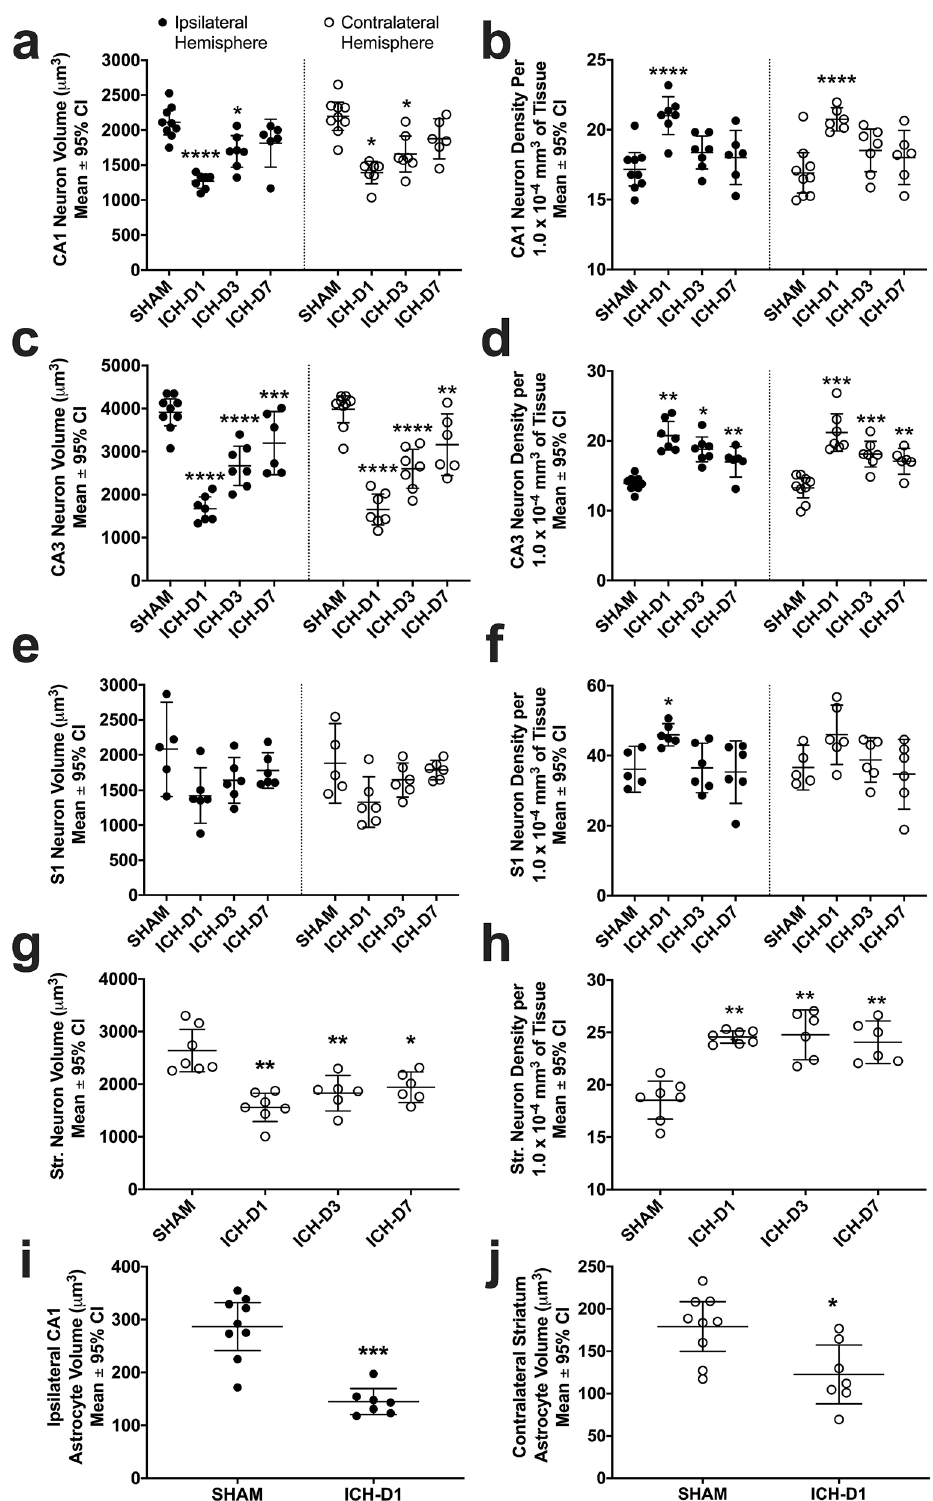
Figure 2. In experiment 1, neuron soma volume ( a , c , e , g ) and density ( b , d , f , h ) were analyzed with unbiased stereology on days 1, 3, and 7 following striatal ICH or sham operation. Astrocyte soma volume was also analyzed on day 1. Areas assessed in all animals included in CA1 ( a , b , i ), CA3 ( c , d ), S1 ( e , f ), and contralateral striatum ( g , h , j ). Ipsilateral striatum was not assessed as it was largely destroyed by the ICH, as expected. * p < 0.05, ** p < 0.01, *** p < 0.001, **** p < 0.0001 versus respective SHAM controls. Scatterplots were made using GraphPad Prism version 8.4.3 for macOS, GraphPad Software, San Diego, California USA, www.graph